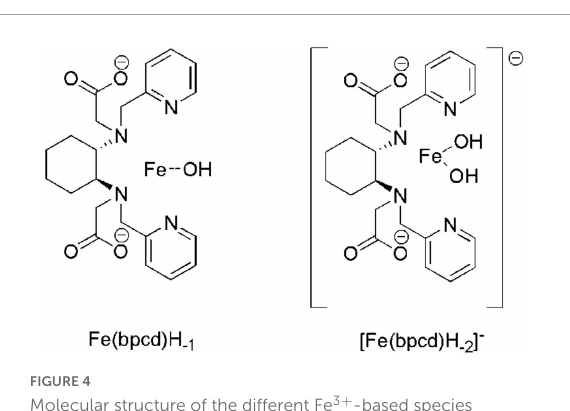
FIGURE4 Molecular structure of the different Fe 3 + -based species observed in aqueous solution above pH 3. In Fe(bpcd)H − 1 and [Fe(bpcd)H − 2 ] - species, the ligand/Fe 3 + dative bonds are not